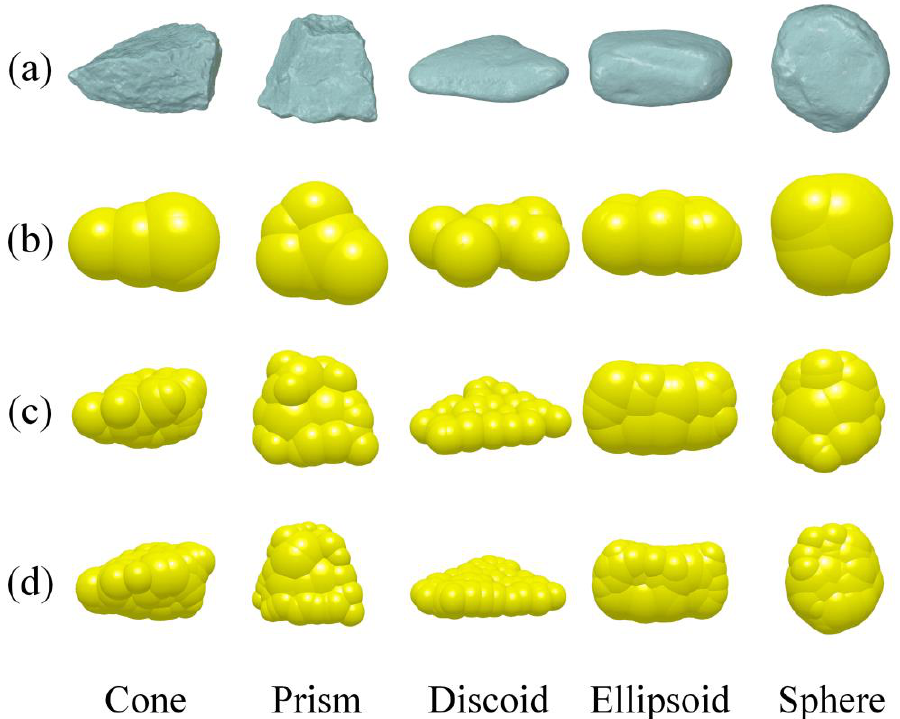
Figure 6. Particle category: ( a ) original 3D scanned model; ( b ) low fill level; ( c ) medium fill level; ( d ) high fill level. Table 2. Model parameters for different fill levels.